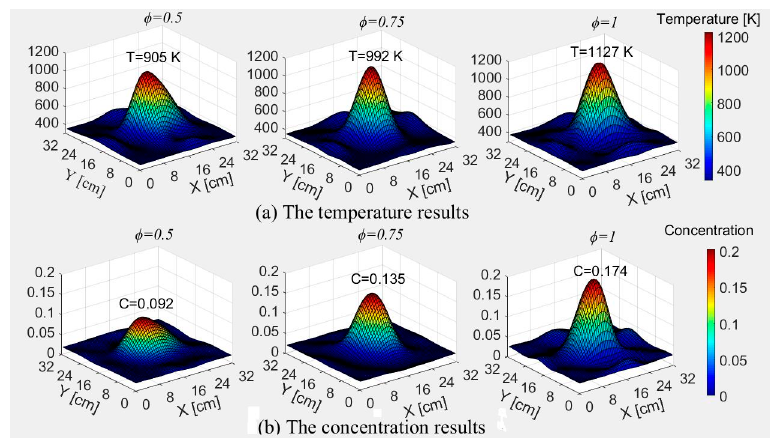
Figure 12. The results of distributions within three kinds of fuel-air equivalence ratio ( ϕ ). ( a ) Temperature distributions and ( b ) H 2 O concentration distributions.